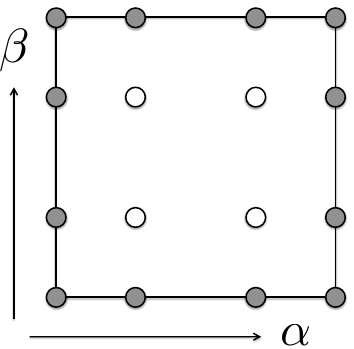
Figure 2. A depiction of the nodal grid for a reference element on Fig. 2. A depiction of the nodal grid for a reference element on GLL nodes for n p = 4 . Boundary nodes, GLL nodes for n p = 4. Boundary nodes, which are connected to which are connected to neighboring elements, are shaded. neighboring elements, are